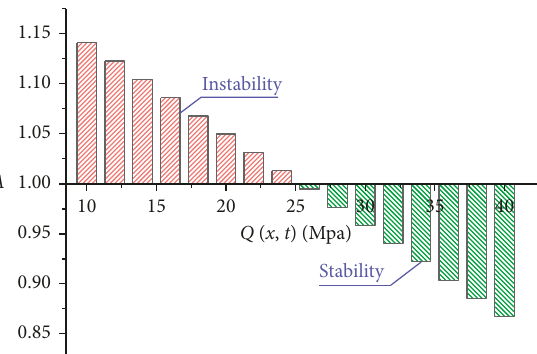
Figure 2: U-shaped steel failure curve. Q ( x,t ) is the sum of uniform load and roof plate disturbance, and A is the factor of safety. The value of A decreases with the increase in elastic modulus Q ( x, t ) . is h